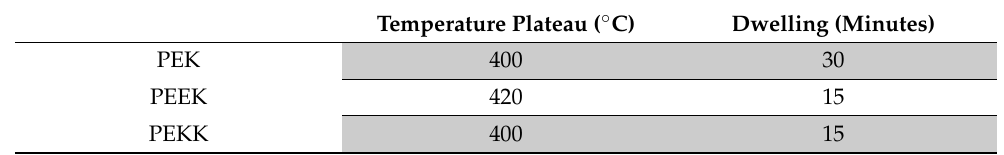
Figure 2. Schematic of the curing cycle performed in the coatings using a convection oven. Table 2. Curing cycle for each binder-based formulation.